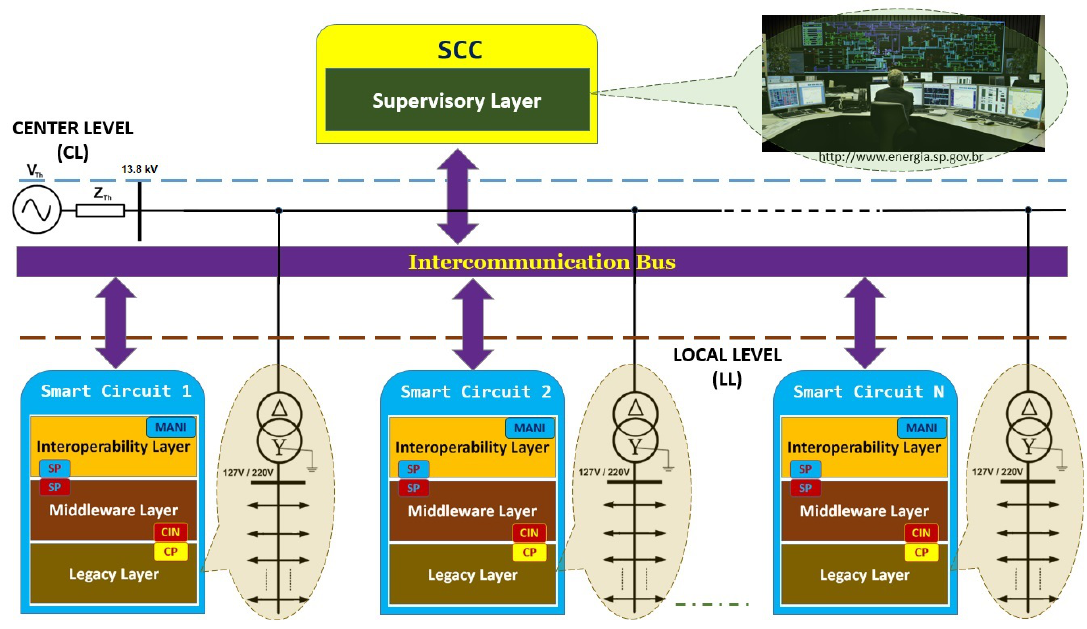
Figure 8. The configuration scheme of SmartLVGrid platform in the distribution